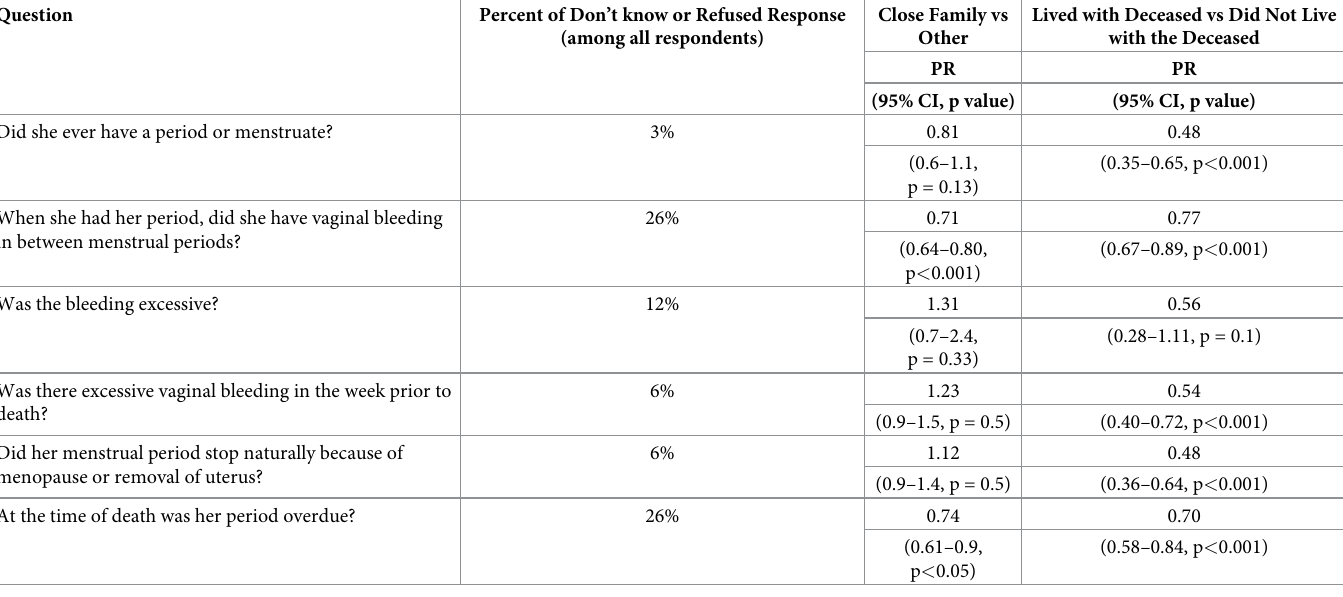
Table 3. Prevalence Ratios (PR) of “Don’t Know” or “Refused” responses among respondents who were close family members of the deceased compared with other relationship to the deceased and lived with the deceased compared with did not live with the deceased.